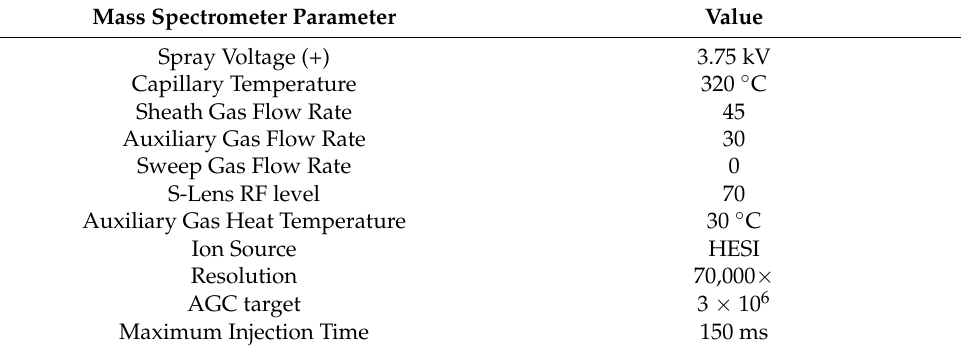
Table 2. General settings of the Q Exactive Orbitrap ESI-MS.